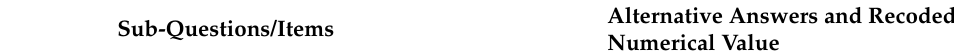
Table 1. Questions Selected from Survey Instrument, Items, Related Alternative Categorical Answer, and Recoded Numerical